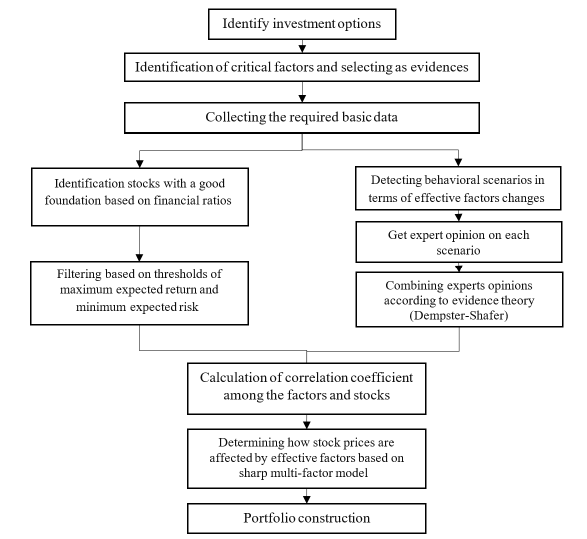
Fig. 1. Conceptual model of this